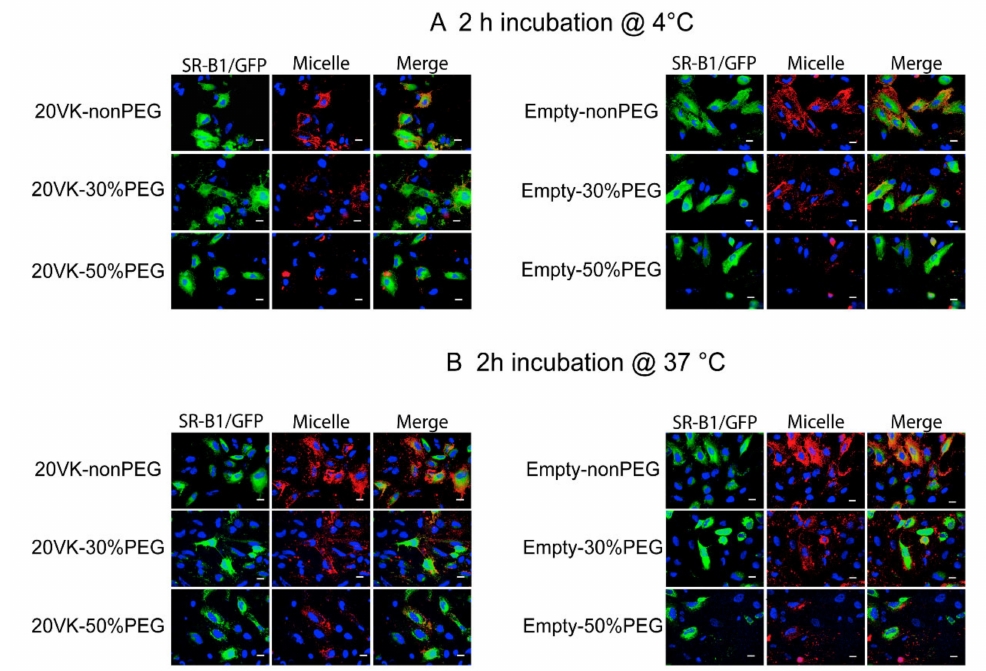
Figure 3. Representative confocal microscopic images of Hela cells overexpressing SR-B1/GFP (green) upon incubation at 4 ( A ) and 37 ◦ C ( B ) with mixed micelles (from top to bottom: non-PEG, 30%-PEG, and 50%-PEG, with the lipid concentration of 1.58 mM) without (empty) and with vitamin K (350 µ M). Micelles were labeled with rhodamine (red); scale bar is 20 µ